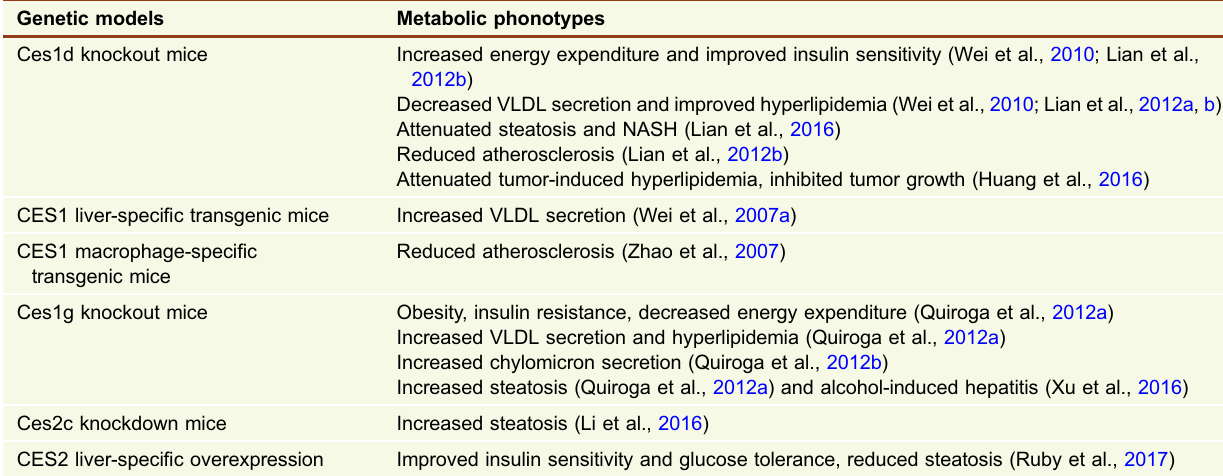
Table 2. Summary of metabolic phonotypes of various carboxylesterase genetic mouse models Genetic